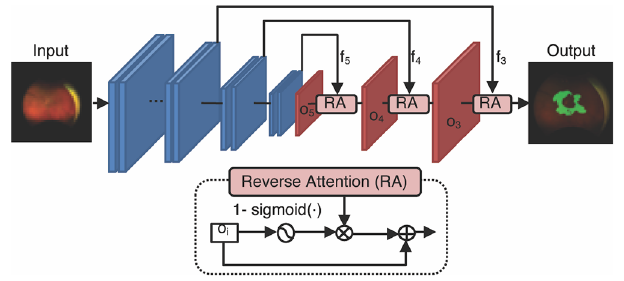
Figure 5. PraNet